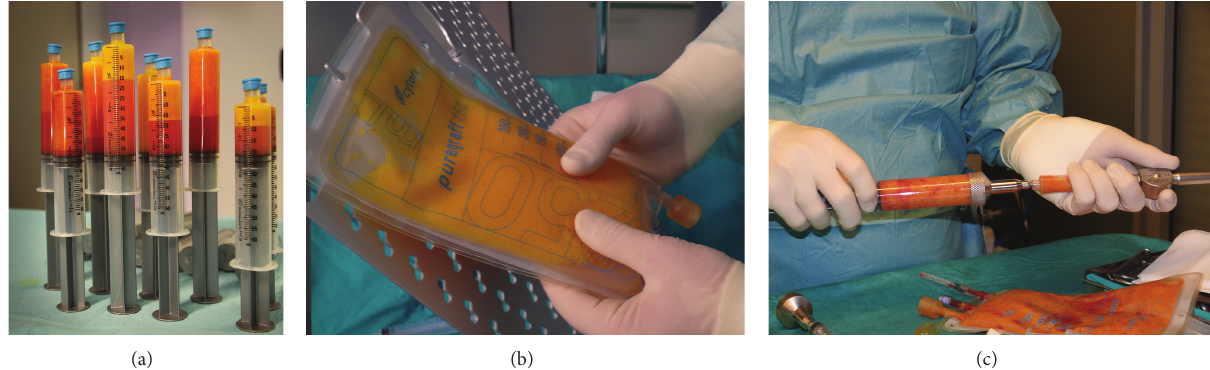
Figure 2: Purified fat and BMMNCs mixture preparation: (a) the harvested fat after tumescent syringe liposuction, (b) the purified fat in Cytori PureGraft 250/PURE System, and (c) the BMMNCs and purified fat mixture transferring to 10mL syringe.